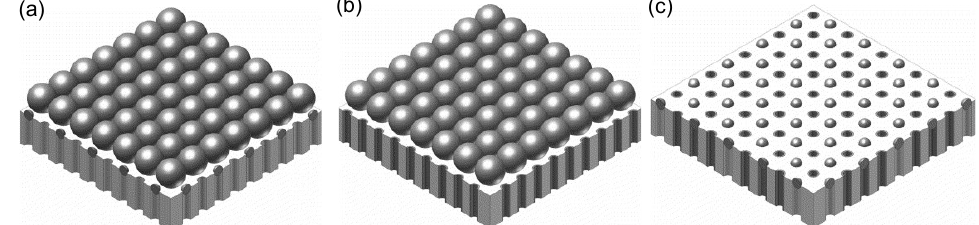
Figure 10. Bolton’s combined models: ( a ) Cake filtration—complete blocking; ( b ) cake filtration— standard blocking; ( c ) complete blocking—standard blocking. Adapted from [138] .